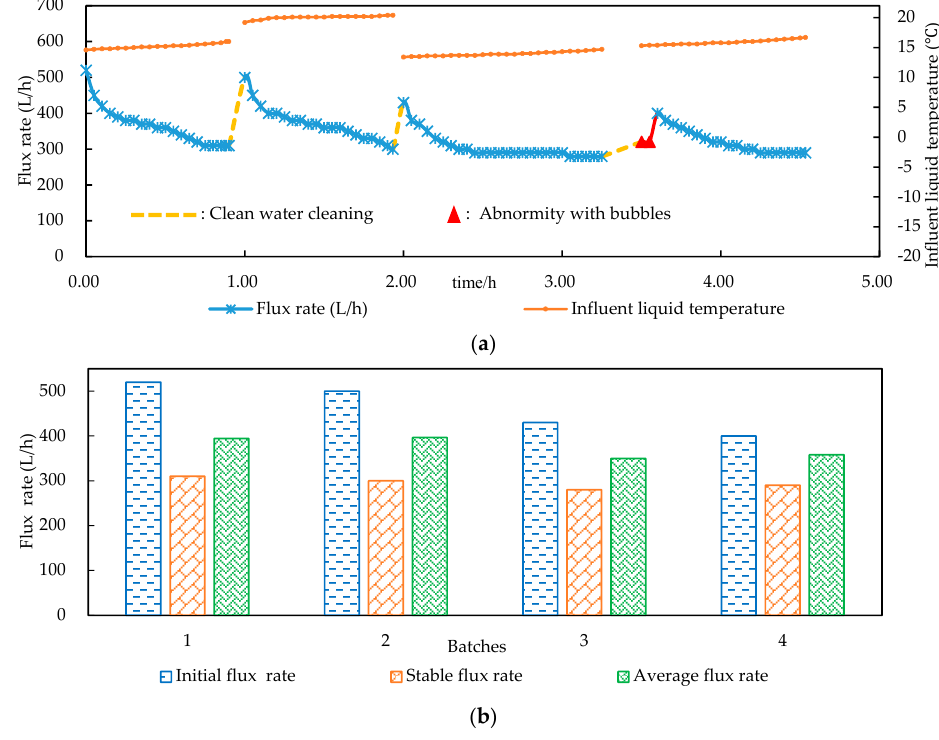
Figure 3. Variations ( a ) and stability analysis ( b ) in the flux rate of multi-batch ultrafiltration process.